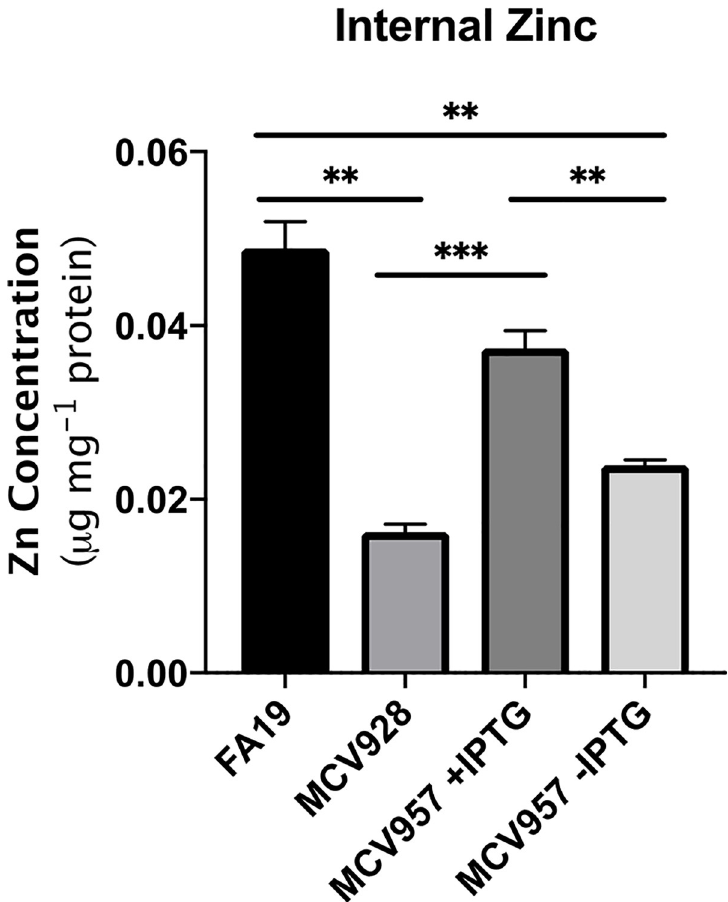
Fig 9. TdfJ internalizes zinc from S100A7. Strains FA19, MCV928 ( tdfJ ), and MCV957 ( tdfJ C ) with and without IPTG were grown in Zn-restricted rich medium supplemented with 2 μ M partially-saturated S100A7. After 6 h cells were harvested and digested in concentrated TMG nitric acid prior to ICP-OES analysis to detect trace metals profile. Data shown are measured μ g zinc/mg cellular protein, read at 213.857 nm, compared to a trace metals standard curve ranging from 5 to 4000 ppb. N = 3 independent cultures. � , P � . 05; �� , P � .005; ��� , P � .0005; ���� , P �